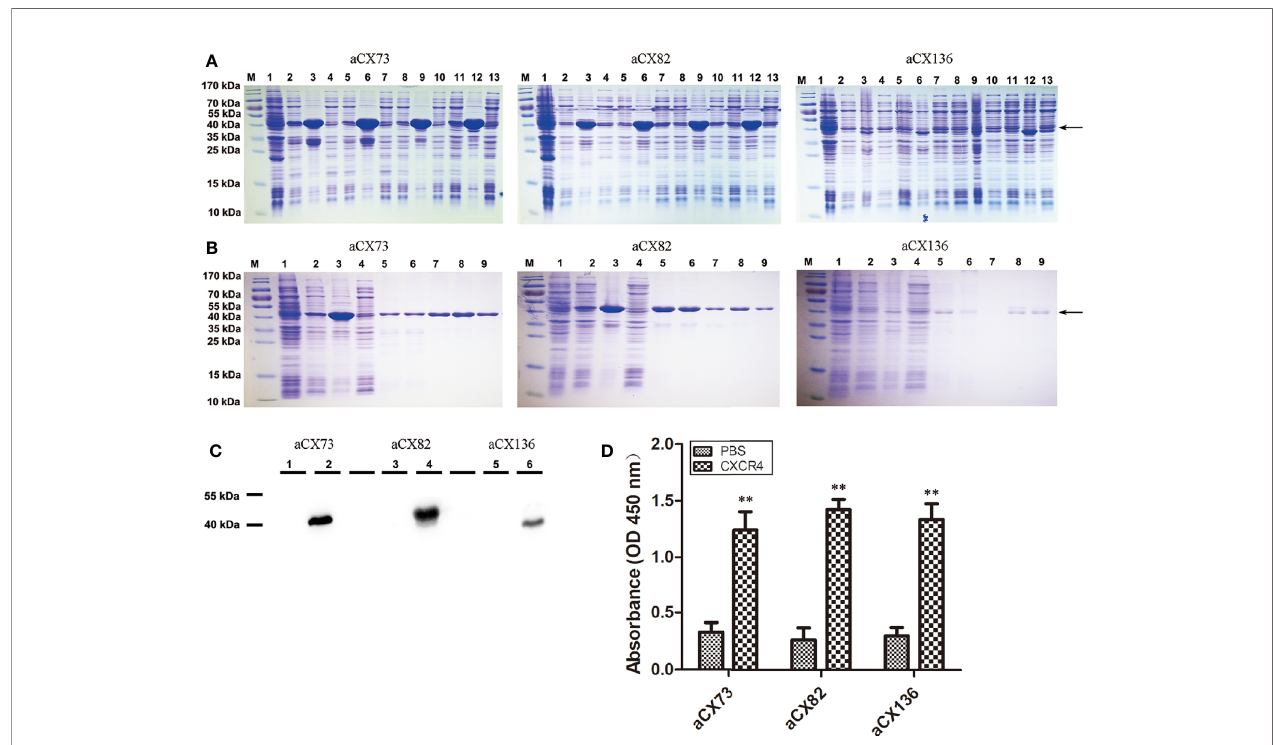
FIGURE 2 | Puri fi cation and analysis of the three anti-CXCR4 scFvs. (A) Detection of the expression of three anti-CXCR4 scFvs (aCX73, aCX82 and aCX136) by SDS-PAGE. M, marker; 1, total proteins of un-induced bacteria; 2 – 4, 5 – 7, 8 – 10, and 11 – 13, proteins of bacteria induced for 6 h with 0.5 mM IPTG at 37°C, 30°C, 25°C, and 18°C, respectively; 2, 5, 8 and 11, total proteins of induced bacteria; 3, 6, 9, and 12, insoluble portion of sonicated induced bacterium lysate; 4, 7, 10, and 13, soluble supernatant of sonicated induced bacterium lysate. (B) scFv puri fi cation and refolding. M: marker; 1, total proteins of un-induced bacteria; 2 – 4, proteins of bacteria induced for 6 h with 0.5 mM IPTG at 30°C; 2, total proteins of induced bacteria; 3, insoluble portion of sonicated induced bacterium lysate; 4, soluble supernatant of sonicated induced bacterium lysate; 5, solubilized inclusion bodies; 6, fl ow-through portion; 7, eluted portion with 0 mM imidazole; 8, eluted portion with 250 mM imidazole; 9, refolded scFvs. (C) The expression of the scFvs was con fi rmed by Western blotting with a mouse anti-His antibody. 1, 3, and 5, total proteins of un-induced bacteria; 2, 4, and 6, total proteins of induced bacteria. (D) ELISA was performed to detect the binding of the three puri fi ed anti-CXCR4 scFvs to the CXCR4 protein purchased. The results represent mean ± S.D (n=5). ** P <